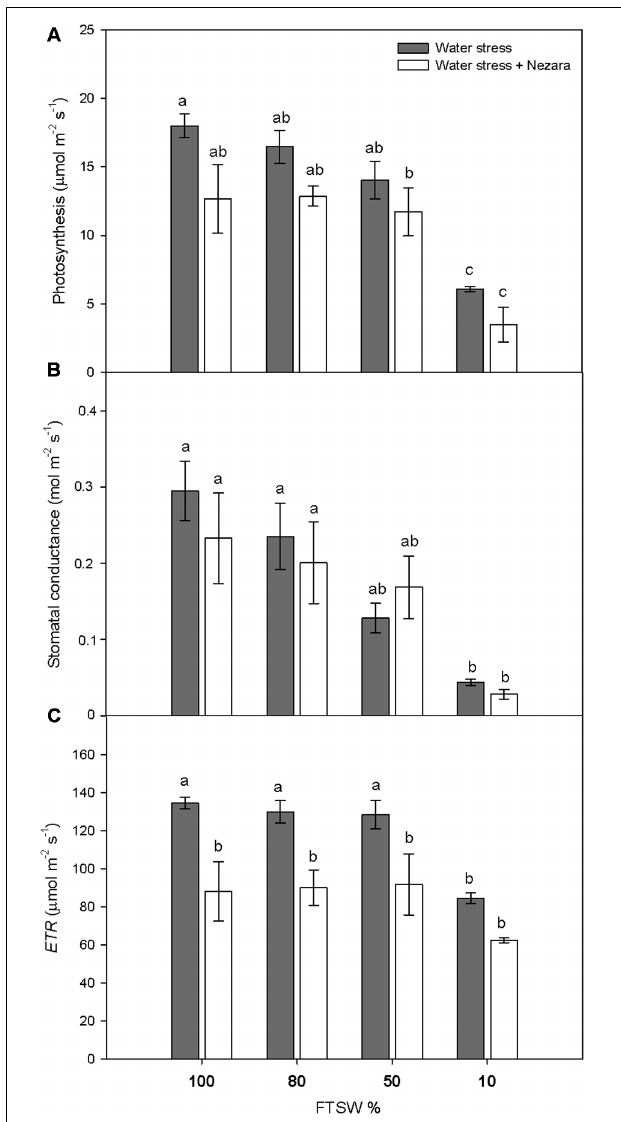
FIGURE 1 | Gas exchange measurements in well-watered and water-stressed broad bean plants with or without Nezara viridula infestation. Leaf photosynthesis (A) , stomatal conductance (B) , and electron transport rate ( ETR ) (C) , of Vicia faba plants under developing water stress (gray bars) and with an associated presence of N. viridula infestation (white bars). Measurements were made at 100% (well-watered plants), and 80, 50, and 10% of fraction of transpirable soil water (FTSW). Data are means ± SE ( n = 8). Different letters indicate significant differences ( P <